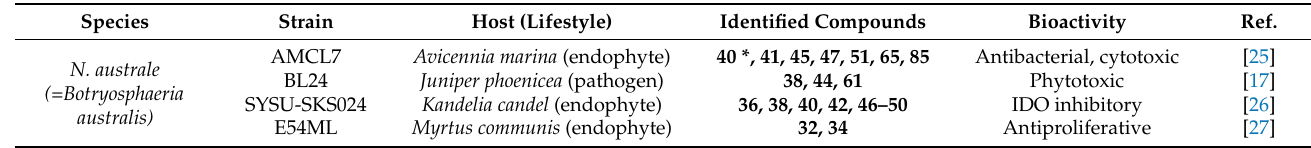
Table 2. Occurrence of secondary metabolites in Neofusicoccum